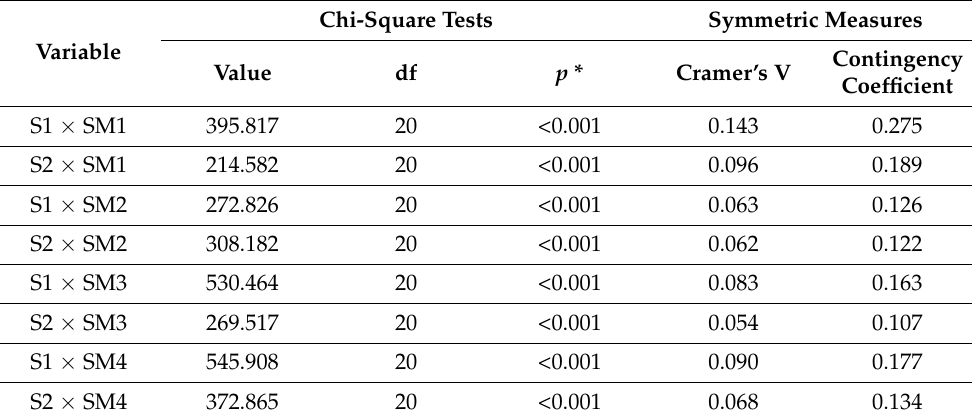
Table 4. Sustainability vs. Smart Mobility—chi-square tests results.